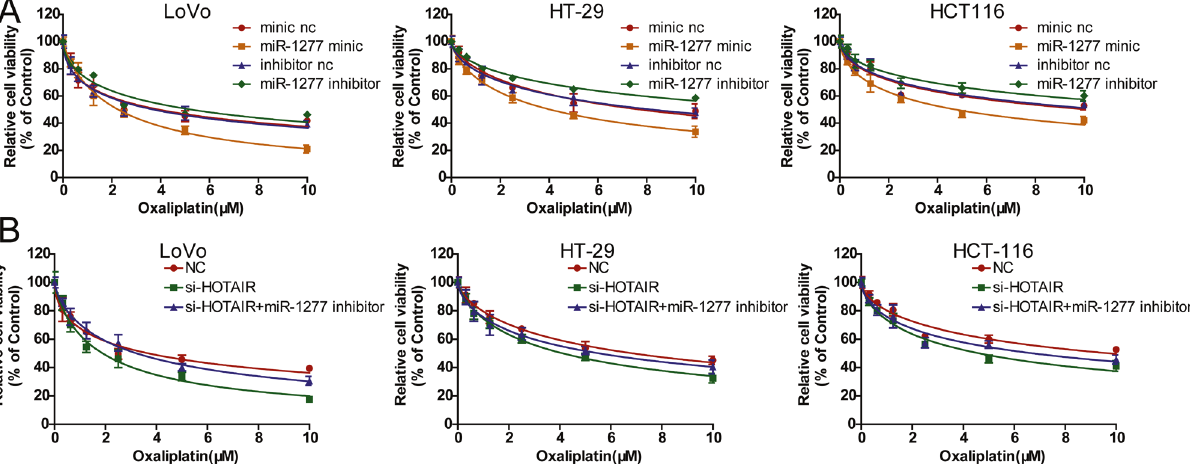
Fig. 6 Knockdown of HOTAIR sensitized CRC cells to oxaliplatin by regulating miR-1277-5p. A CCK-8 was used to measure the cell viability of CRC cells transfected with miR-1277-5p mimic, miR-1277-5p inhibitor, or corresponding negative control. B CCK-8 was used to measure the cell viability of CRC cells transfected with NC, HOTAIR siRNA, HOTAIR siRNA + miR-1277-5p inhibitor. arrested by the treatment of sh-HOTAIR and oxaliplatin. These in vivo results con fi rmed that HOTAIR knockdown increased oxaliplatin sensitivity in CRC.